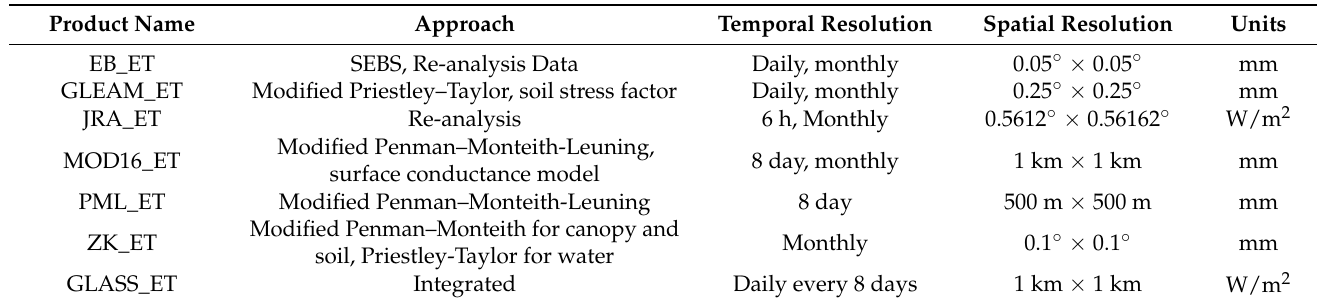
Table 1. Information about ET product datasets evaluated in this study.